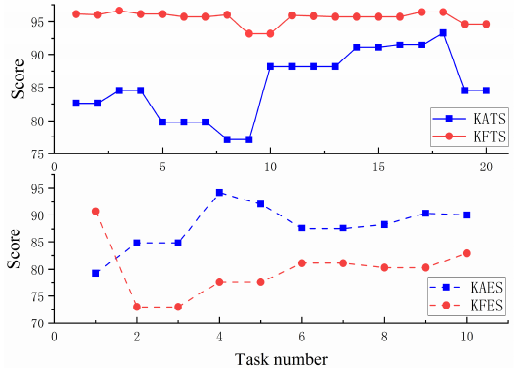
Figure 17. The evolution of the 𝑆𝑐𝑜𝑟𝑒 of S1 in different stages. The top half of the image shows the comparison of 𝑆𝑐𝑜𝑟𝑒 during the training stage and the bottom half of the image shows the comparison of scores during the evaluation stage.